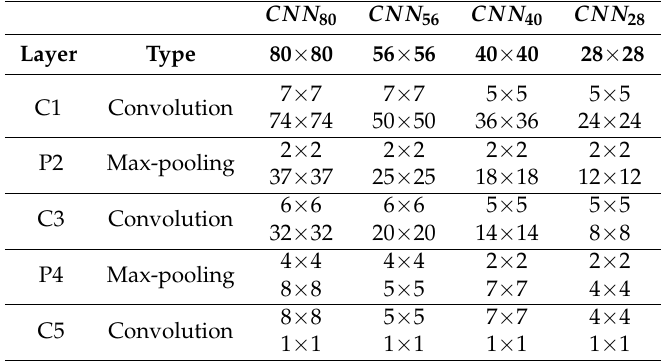
Figure 6. Example of Extraction phase by CNN. Table 1. Network architectures in each box of the table; Top: size of the segmented eye image and Bottom: size of the